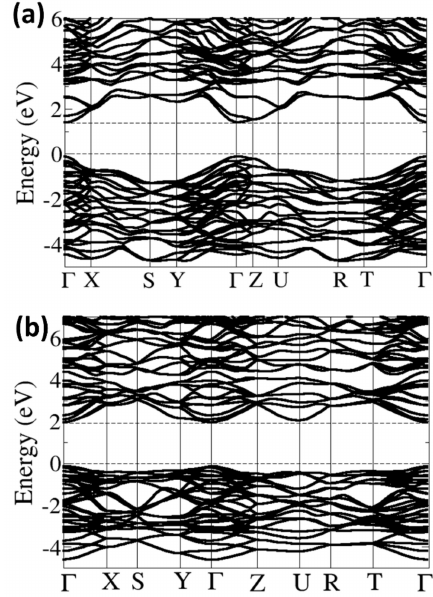
Figure 4. Band structure along the high–symmetry directions of the Brillouin zone of ( a ) α –SrZrS 3; and ( b ) β –SrZrS 3 .